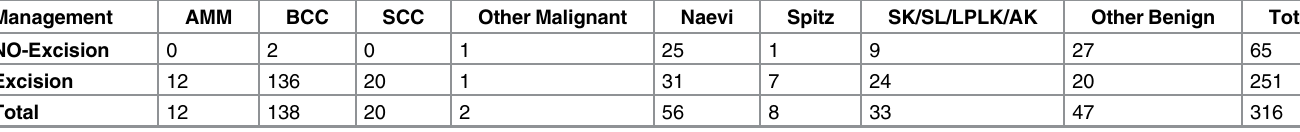
Table 2. Double reader